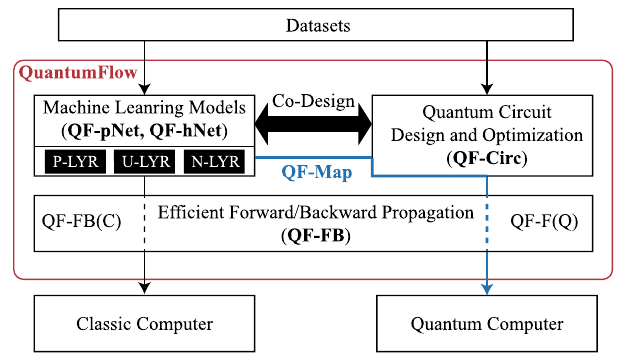
Fig. 1 Illustration of the proposed end-to-end co-design framework, QuantumFlow. QuantumFlow provides a missing link between neural network and quantum circuit designs, which is composed of QF-pNet, QF- hNet, QF-FB, QF-Circ, QF-Map that work collaboratively to design neural networks and their quantum